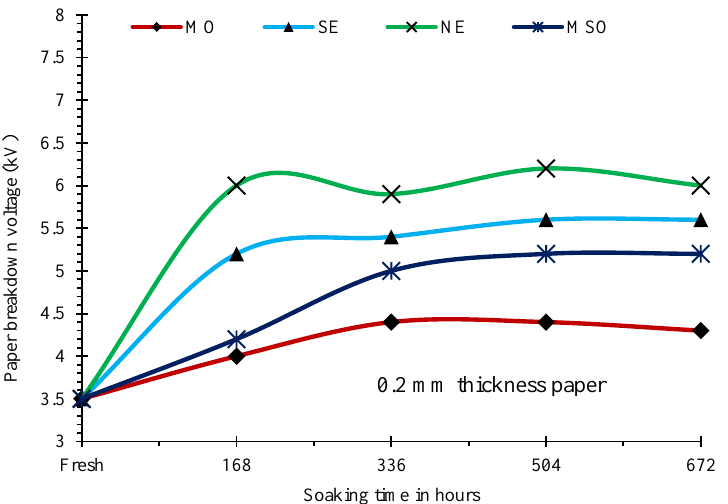
Figure 3. Wetting characteristics of 0.2 mm thickness papers without thermal stressing in various insulating oils.